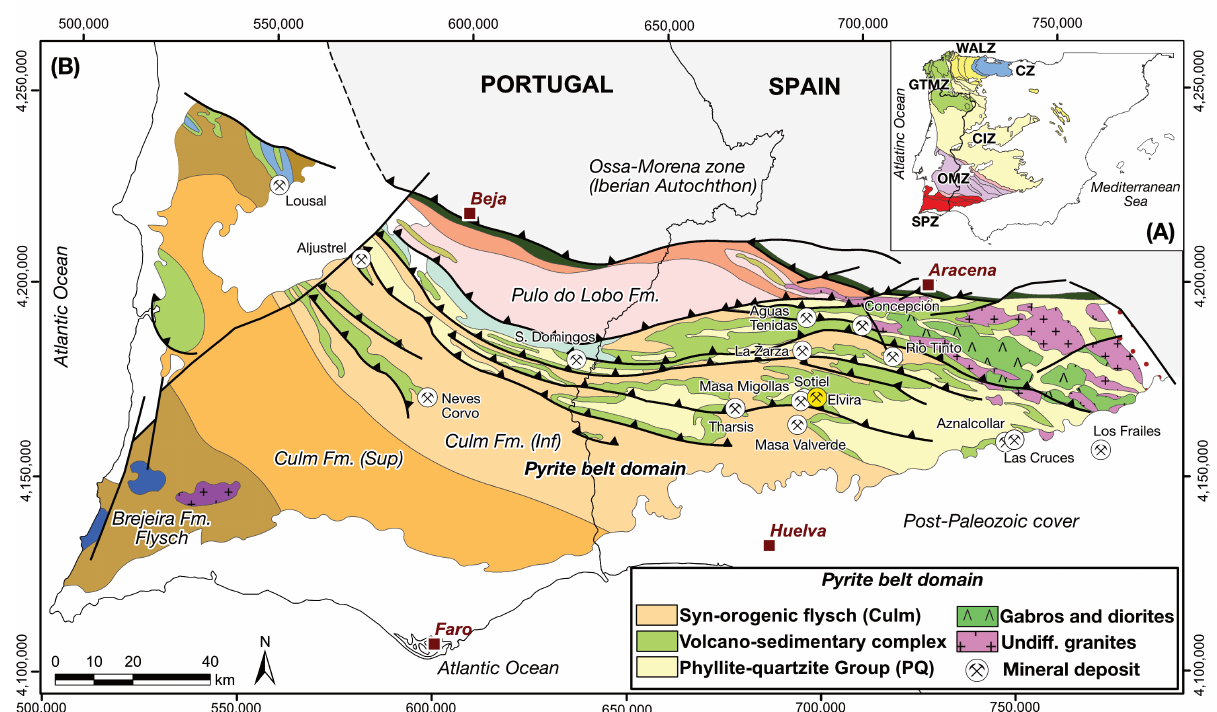
Figure 4. ( A ) Iberian Massif Zones, CZ: Cantabrian Zone. WALZ: West Asturian-Leonese Zone. GTMZ: Galicia Tra’s os Montes Zone. CIZ: Central Iberian Zone. OMZ: Ossa Morena Zone. SPZ: South Portuguese Zone. ( B ) Geological scheme of the South Portuguese Zone with the location of main massive sulfide deposits in the IPB, highlighting in yellow the Elvira deposit. Map coordinate system: UTM Zone 29 ETRS 89. Modified from